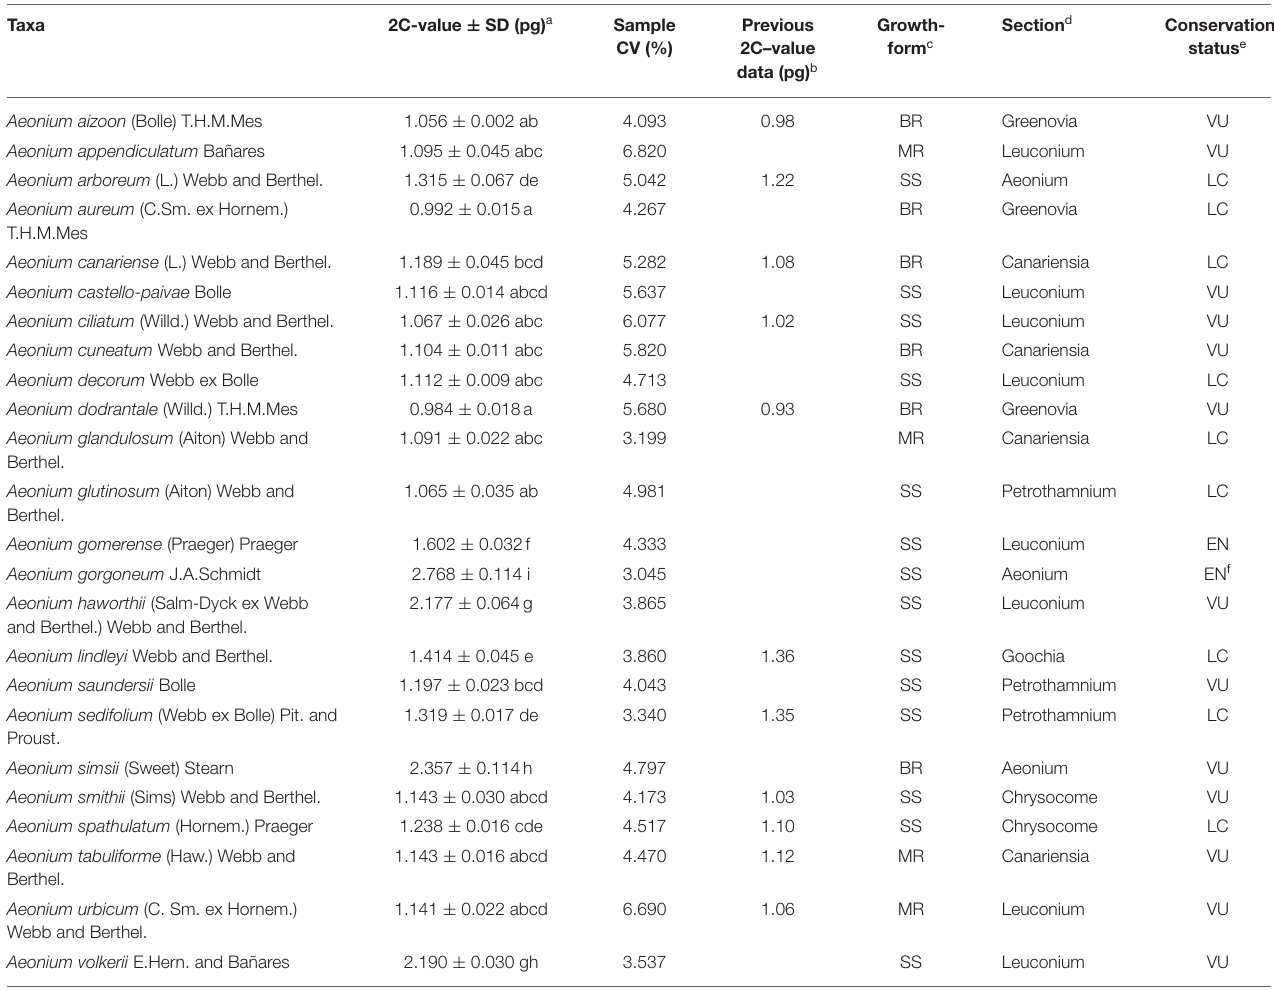
TABLE 2 | Average 2C-value in picograms with standard deviation (SD), sample coefficient of variation, previous 2C-value estimates in picograms, growth-form, section, and conservation status of 24 Aeonium (Crassulaceae) taxa from